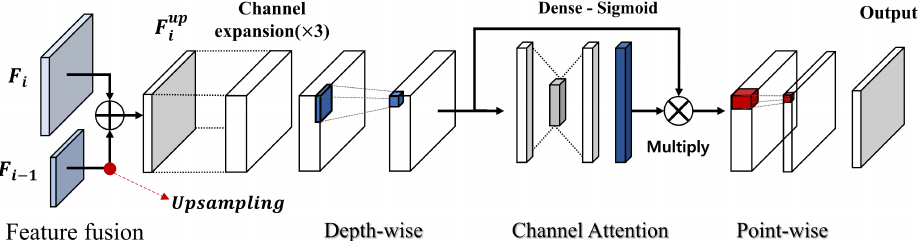
Figure 3. Feature refining process.